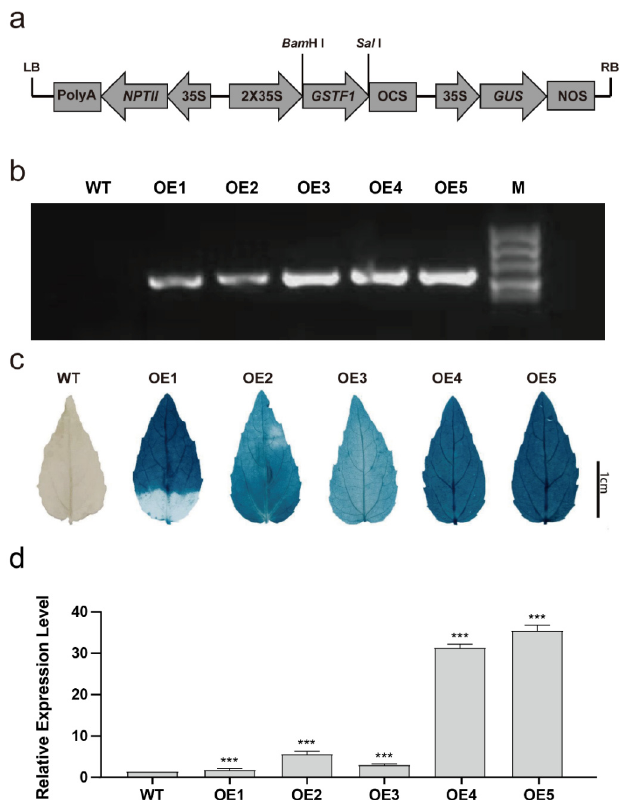
Figure 2. Generation and molecular confirmation of transgenic poplars. ( a ) Diagram of the PtGSTF1 overexpression vector. Expression of PtGSTF1 was driven by the cauliflower mosaic virus 35S ( CaMV 35S ) promoter. ( b , c ) PCR and GUS staining analysis of wild type (WT) and different independently regenerated PtGSTF1 transgenic lines. ( d ) qRT-PCR analysis of PtGSTF1 expression in WT and different transgenic lines. WT, wild type; OE1, OE2, OE3, OE4 and OE5, different transgenic lines overexpressing PtGSTF1 . Values are the mean ± SD (standard deviation) from three independent experiments ( n = 3). ***, p < 0.001.